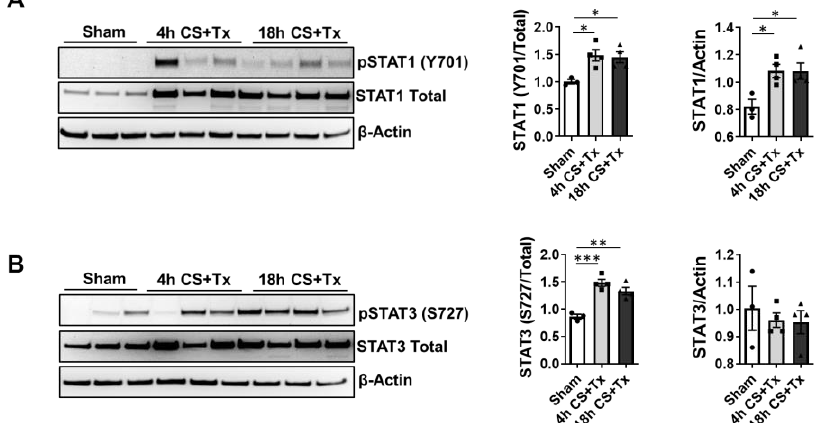
Figure 9. Phosphorylated and total STAT proteins remain elevated in renal allografts after 9 days post-surgery. Experimental groups reflect levels of CS exposure: Sham (no CS, right nephrectomy), 4 h CS + Tx (Fischer to Lewis rats), and 18 h CS + Tx (Fischer to Lewis rats). Surgical procedures were performed as described in Methods. ( A , B ) 30 µ g of RIPA extracts prepared from kidney homogenates were subjected to SDS-PAGE and Western blot analysis of ( A ) STAT1 (Y701-phosphorylated and total protein) and ( B ) STAT3 (S727-phosphorylated and total protein) after Sham, 4 h CS + Tx, or 18 h CS + Tx. Data are the mean ± SEM (bars, n = 3), and representative blots are pictured. Differences between group means were compared with 1-way ANOVA followed by Brown–Forsythe and Welch’s corrections for multiple group comparisons; p < 0.05 was considered significant. *, p < 0.05; **, p < 0.01, ***, p < 0.001. Each solid circle, square, or triangle represent individual animals within the